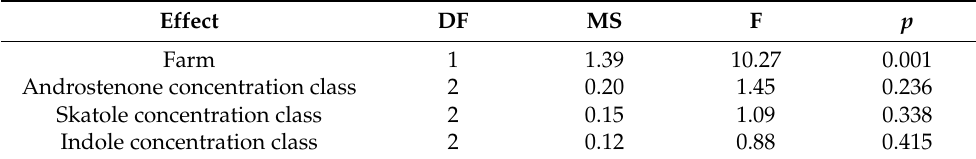
Table 3. ANOVA table for the duration of the training session ( n =